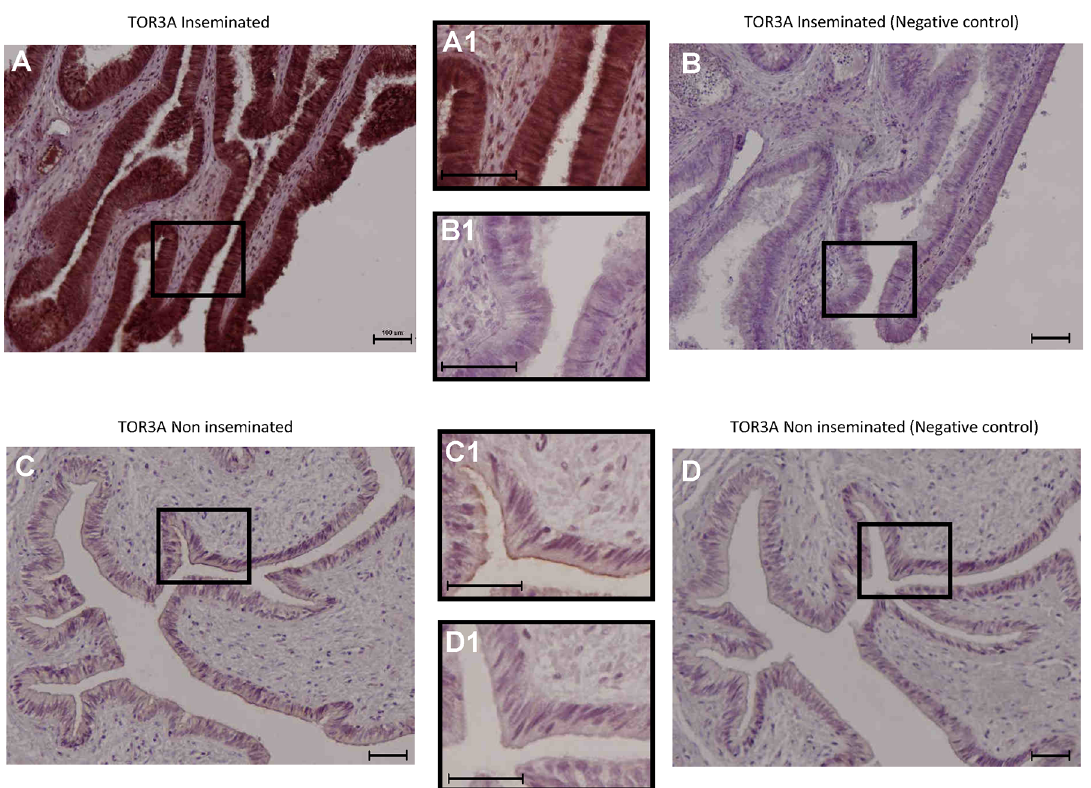
Fig 7. Immunohistochemical localization of TOR3A in the porcine oviduct. Strong immunostaining for TOR3A protein was only observed in the oviductal wall of the inseminated sows (Fig 7A, magnified in 7A1). The labelling was absent in non-inseminated animals (Fig 7C magnified in 7C1) as well as in the corresponding negative controls for the inseminated (Fig 7B, magnified in 7B1) and non-inseminated sows (Fig 7D, magnified in 7D1). In all figures, scale bars correspond to 100 μ